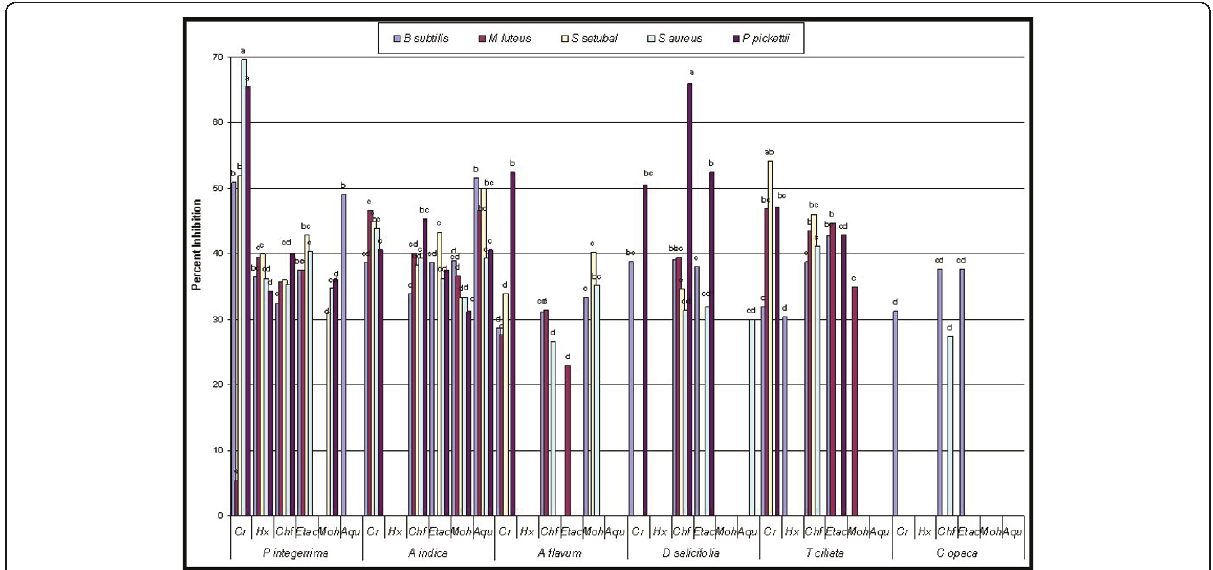
Figure 2 Comparative percent inhibition of thirty six extracts from six medicinal plants against different bacterial strains . Alphabets on bars represent LSD values at p < 0.05. Cr = Crude extract, Hx = Hexane fraction, Chf = Chloroform fraction, Etac = Ethyl acetate fraction, Moh = Methanol fraction, Aqu = Aqueous